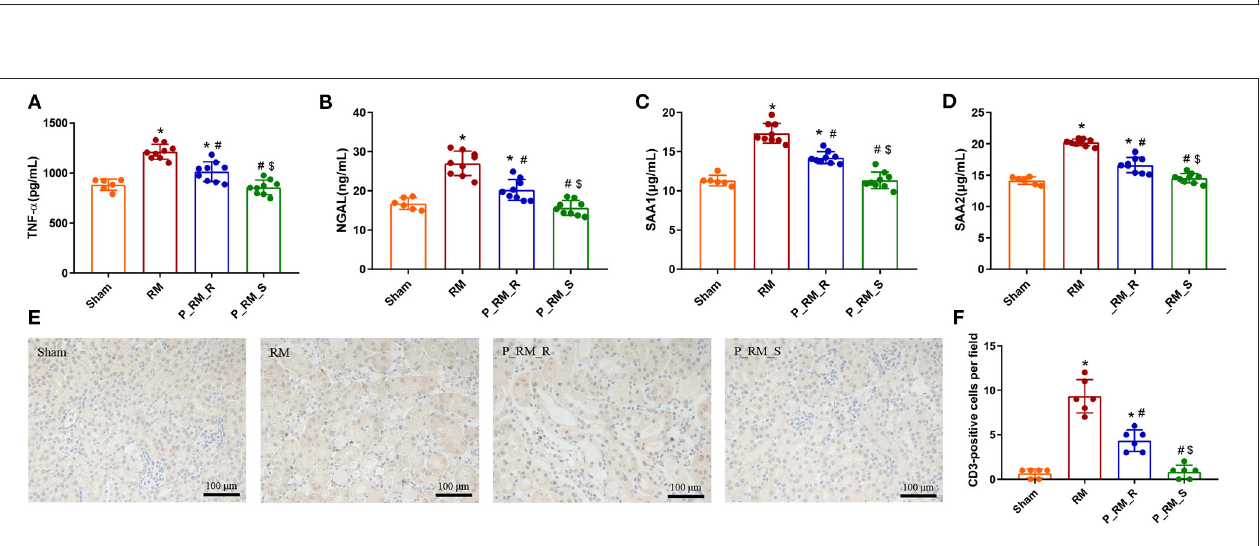
FIGURE 7 | Exogenous biological renal support decreased inflammation in RM-induced AKI. (A–D) The levels of TNF- α , NGAL, SAA1, and SAA2 were measured by ELISA. (E) Representative images of renal CD3 expression in the four groups. (F) Comparison of the CD3-positive cells per field. TNF- α , tumor necrosis factor α ; NGAL, neutrophil gelatinase-associated lipid carrier protein; SAA, serum amyloid A protein; RM, rhabdomyolysis; P_RM_R, the mouse in the parabiosis model administered glycerol; P_RM_S, the other mouse in the parabiosis model supplying the exogenous biological renal support. * P < 0.05 vs. the sham group; # P < 0.05 vs. the RM group; $ P < 0.05 vs. the P_RM_R